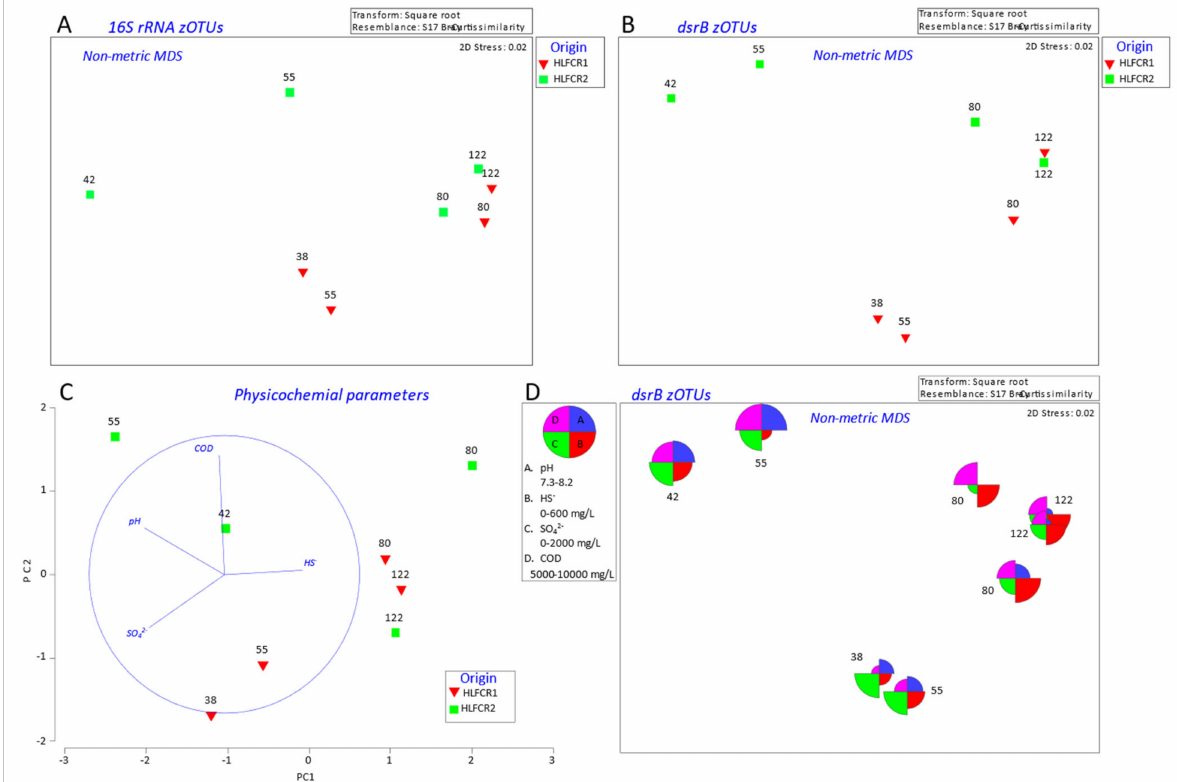
Figure 4. nMDS plots with data points representing Bray–Curtis similarities of transformed: 16S rRNA amplicon zOTU samples ( A ) and dsrB amplicon zOTU samples ( B ). PCA plot of Euclidean distance similarity of transformed physicochemical data ( C ), and bubble overlays of physicochemical data on plot B ( D